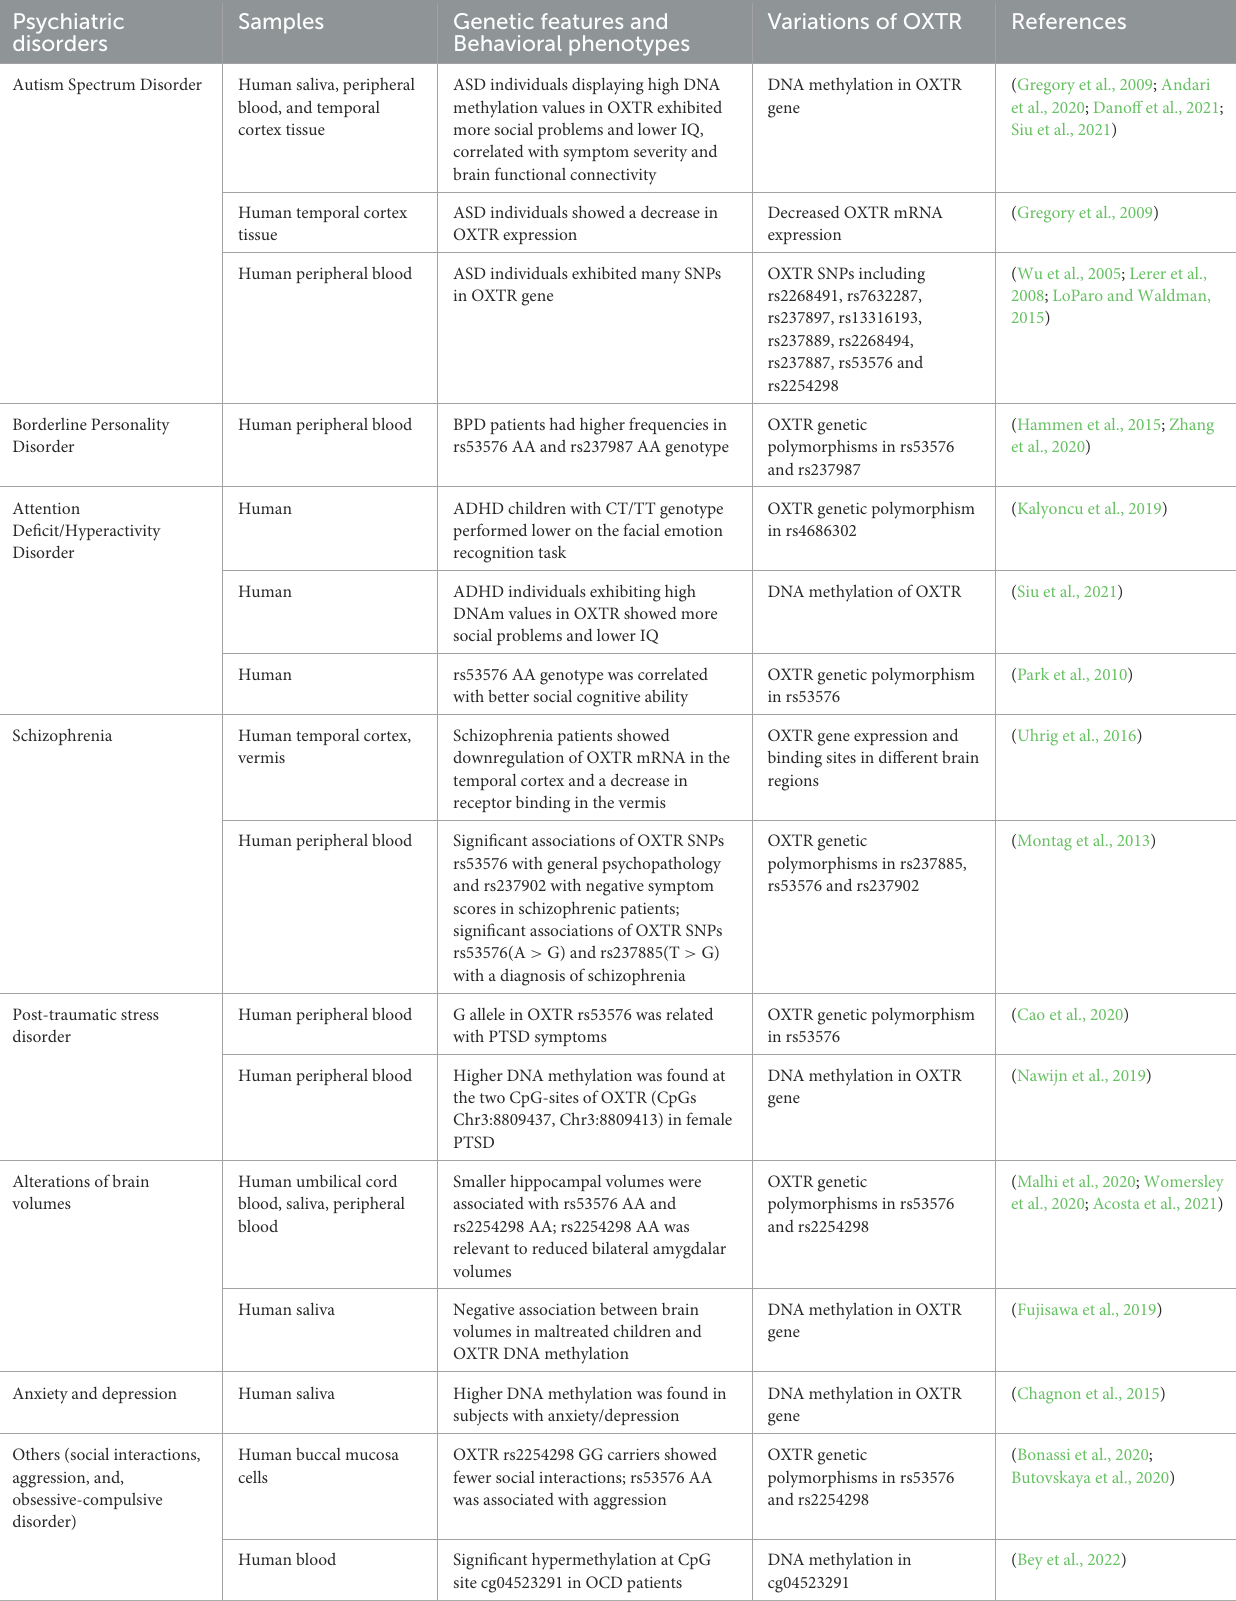
TABLE 2 Summary of aberrant OXTR in psychiatric disorders and alterations of brain